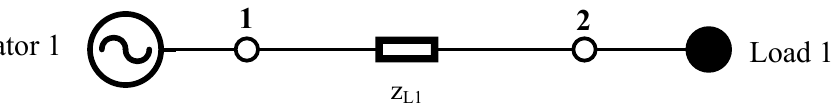
Figure 1. Model of the grid for a one-phase OPF algorithm.